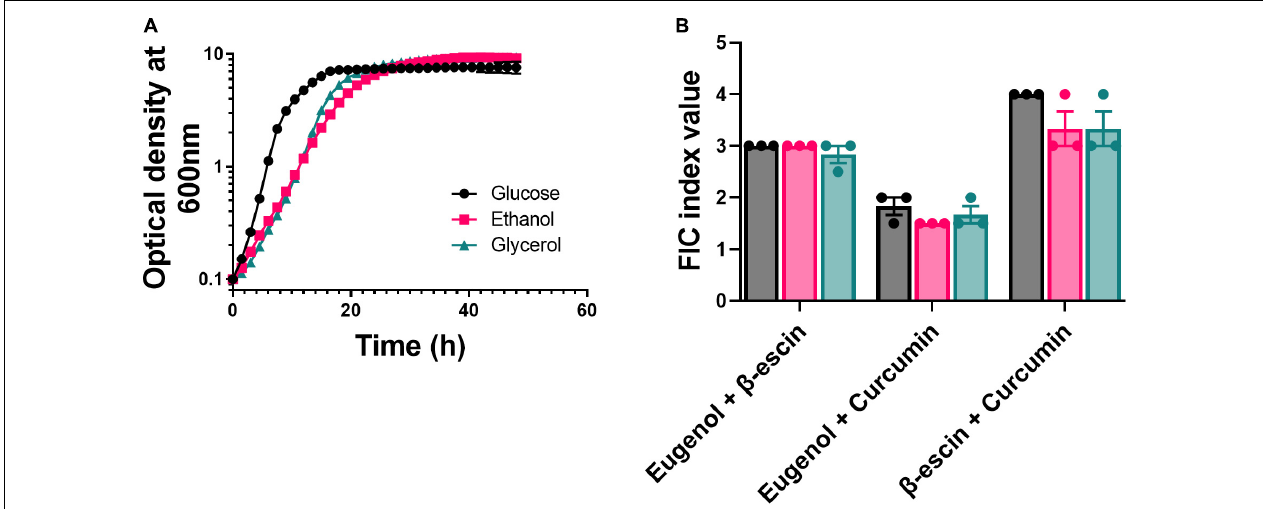
FIGURE 2 | Effect of metabolic environment on the stability of combinatorial interactions. (A) Growth curves for S. cerevisiae W303 in YEP medium supplemented with either glucose, glycerol, or ethanol (all at 2% w/v). Each point represents the mean of three independent experiments ± SEM (error bars did not exceed the dimensions of the symbols). (B) S. cerevisiae W303 was treated in checkerboard format with combinations of eugenol, β -escin, and curcumin in YEP supplemented with 2% either glucose (black), glycerol (pink), or ethanol (green). Percentage growth was used to calculate FIC indices. Each bar represents the mean of three independent experiments ± SEM. The corresponding checkerboard data are presented in Supplementary Figure 2